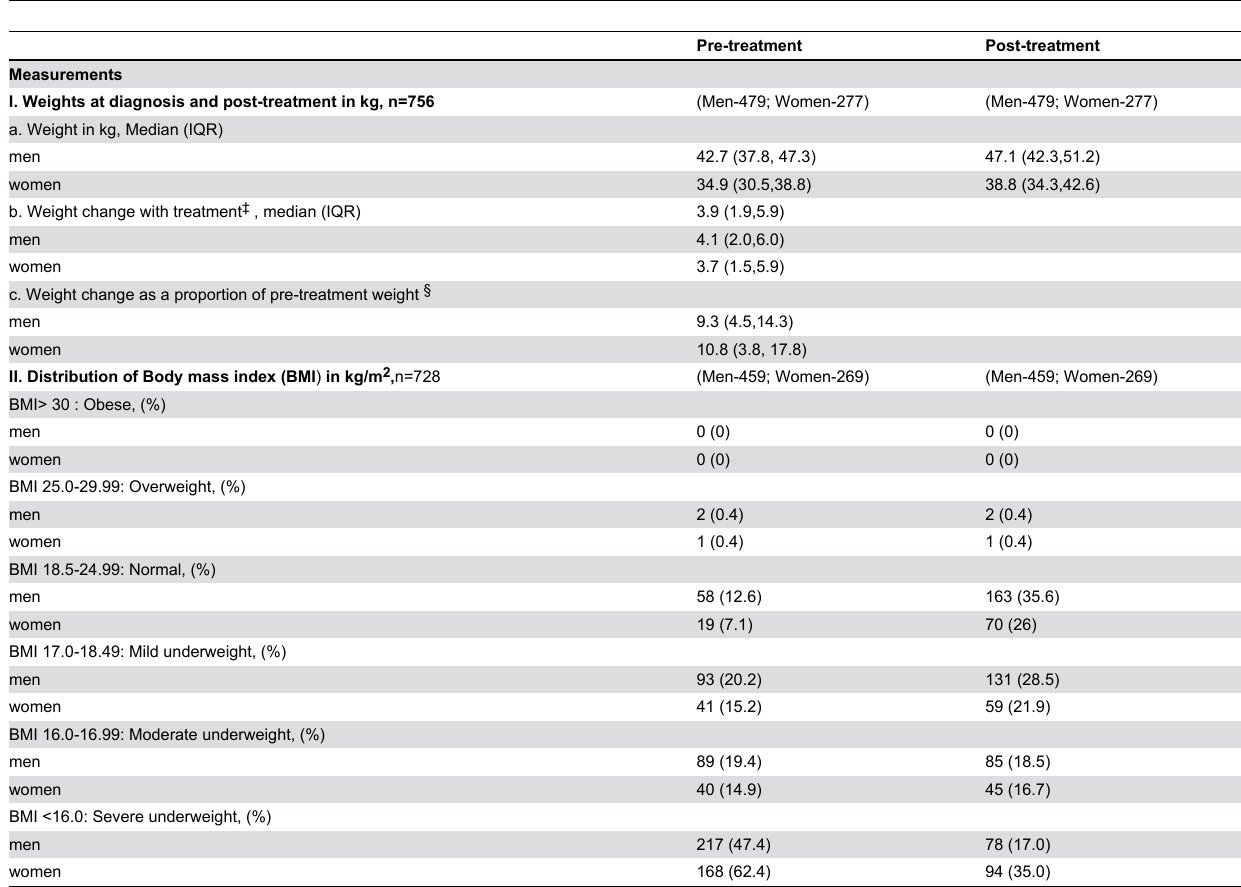
Table 3. Pre-treatment, post-treatment weights & body mass index (BMI) in 756 patients with pulmonary TB who completed treatment successfully,